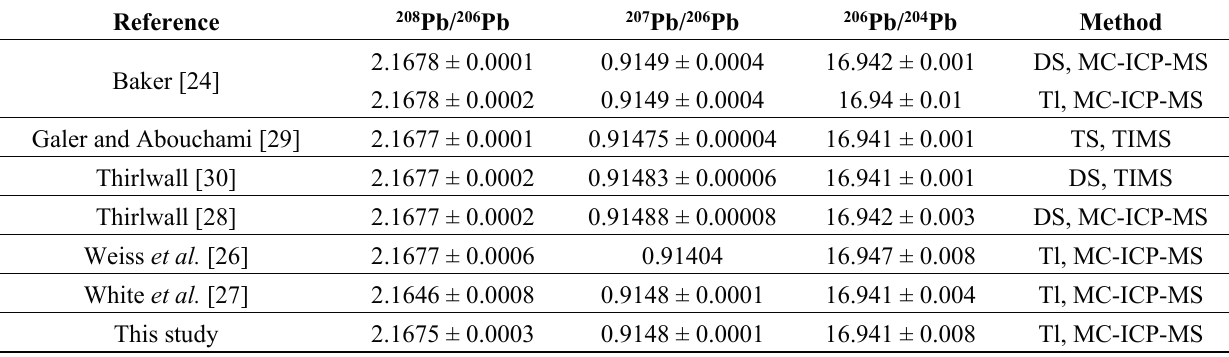
Table 1. Comparisons of precision and accuracy (NIST SRM 981; mean ± 2